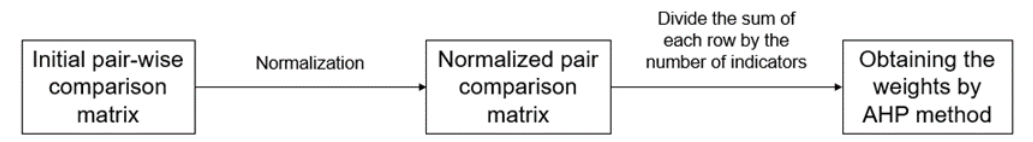
Figure 7. The procedures of weight determination by AHP method.